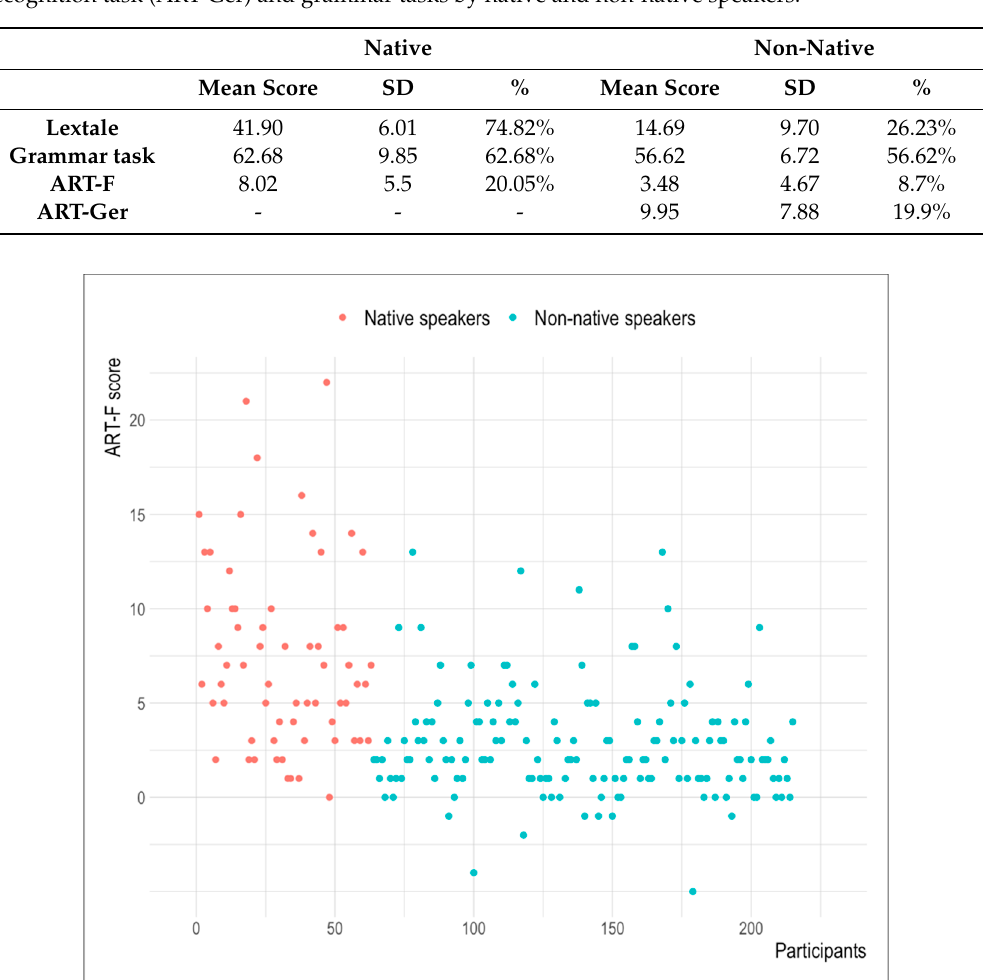
Figure 1. Score of the ART-F per participants.